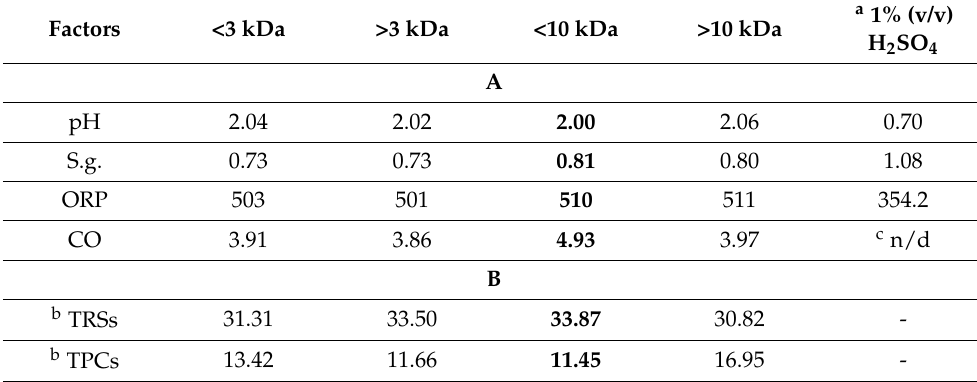
Table 2. Averaged (n =3) physico-chemical properties of the different fractions of N. mirabilis pitcher fluid in comparison to dilute (1% v/v) sulphuric acid (A), and the initial assessment of the best performing fraction in terms of TRSs and TPCs formation